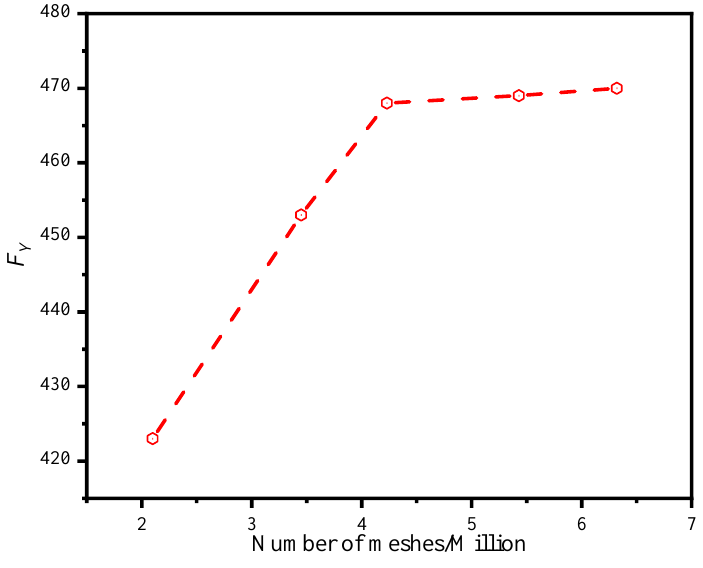
Figure 18. Mesh independence of verification.